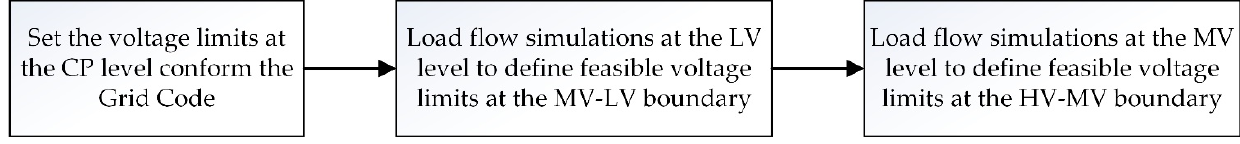
Figure 4. Overview of the methodology used to investigate the voltage limits behavior at distribution and supplying substation levels.